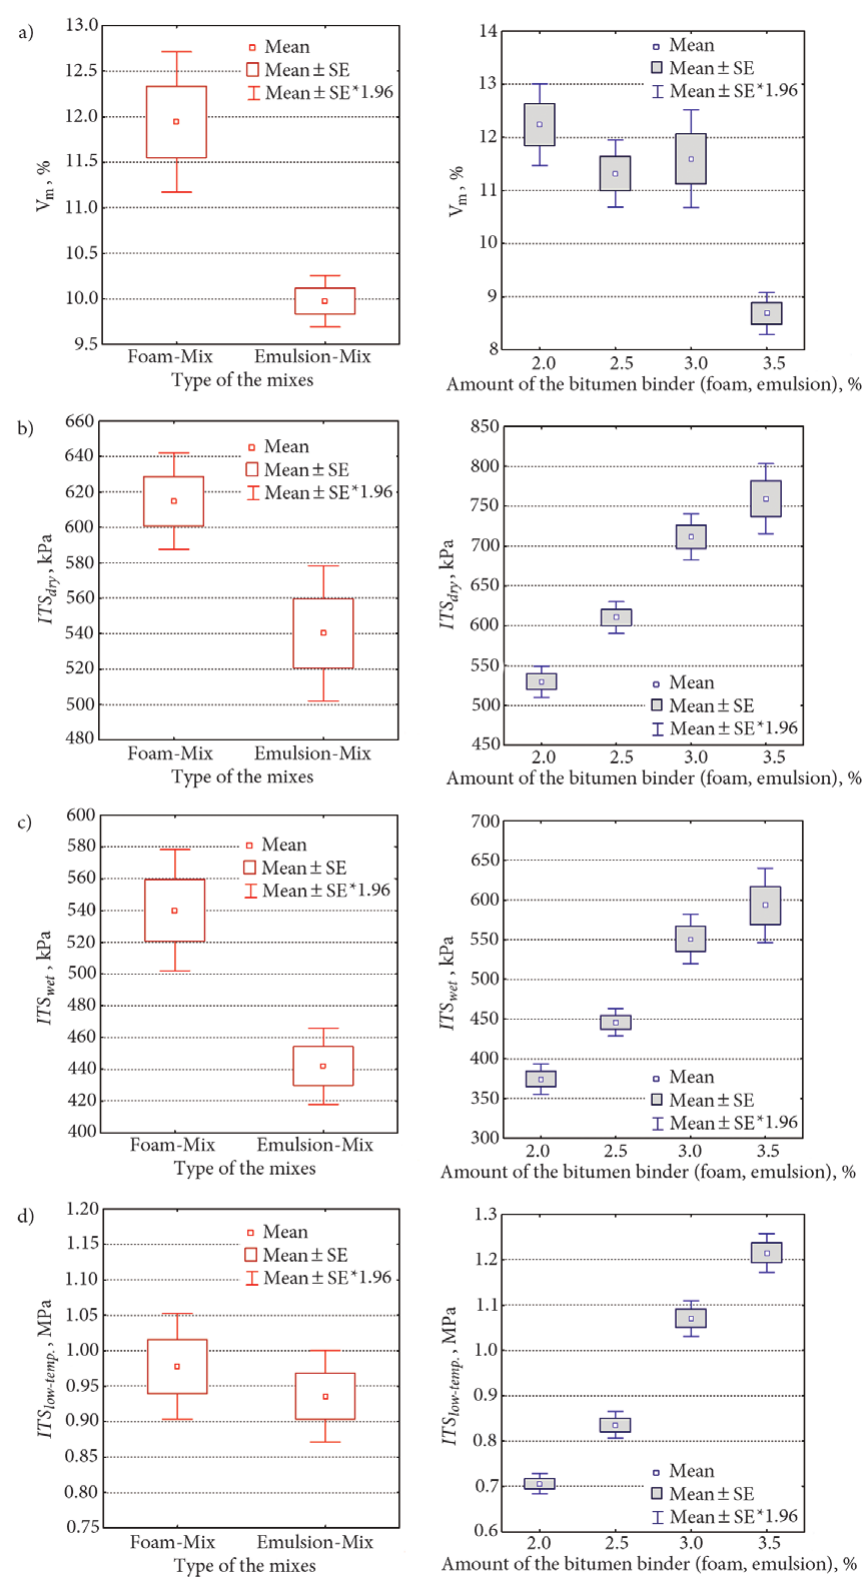
Fig. 9. Distribution of the tested features: a – air void content V m , b – dry indirect tensile strength ITS dry , c – wet indirect tensile strength ITS wet , d – indirect tensile strength before after curing at –2 °C ITS